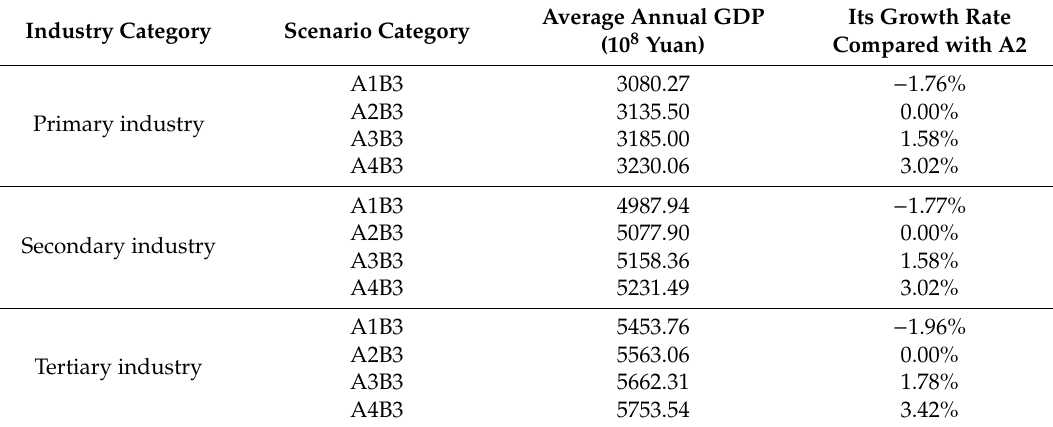
Figure 8. The simulation results of socio-economic and water impacts of 4 water diversion quantity from transboundary river basins under B3, ( a ) Primary Industrial GDP, ( b ) Secondary Industrial GDP, ( c ) Tertiary Industrial GDP, ( d ) Water Shortage. Table 8. Average annual output value of various industries and its growth rate compared with A2 under B3.